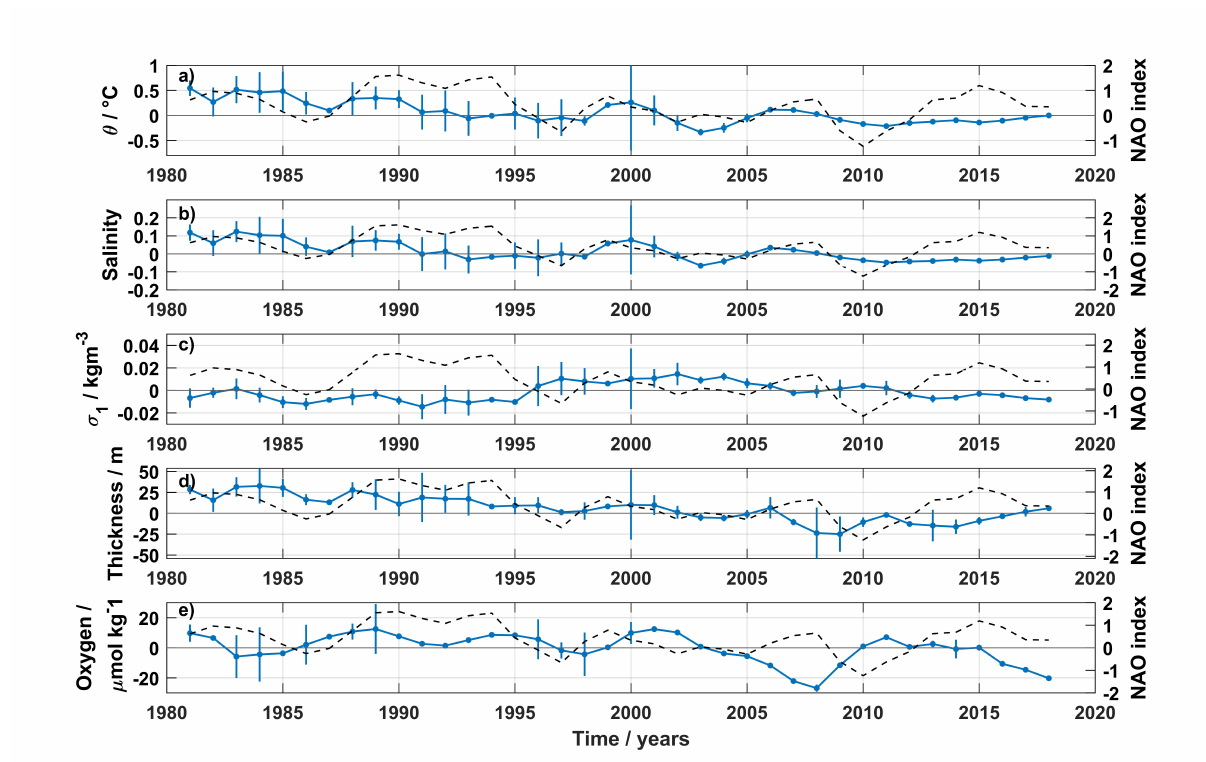
Figure 2. Annual mean anomaly time-series (1981–2018) of potential temperature ( a ), salinity ( b ), potential density ( σ 1 , corresponding to 1000dbar) ( c ), thickness ( d ) and dissolved oxygen ( e ) averaged at the core of MOW (between 1000 and 1100dbar). Black dashed line is the 3-years moving mean NAO-winter index [46]. The annual anomalies were averaged over the entire study area in Figure 1a and smoothed using a 3-year moving average. Error bars represent the standard error of the mean. Points without error bars were interpolated using a 3-point mean